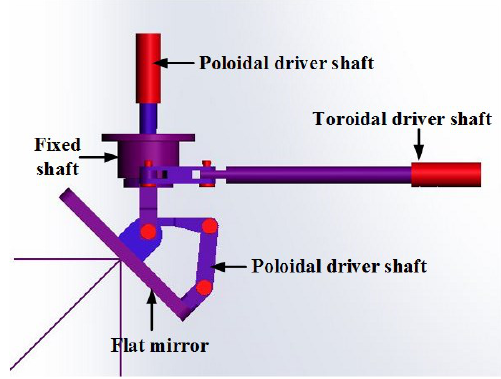
Fig. 3 . Steering mechanism of the flat mirror. Table 5 . Parameters of ellipsoidal mirror and flat mirror